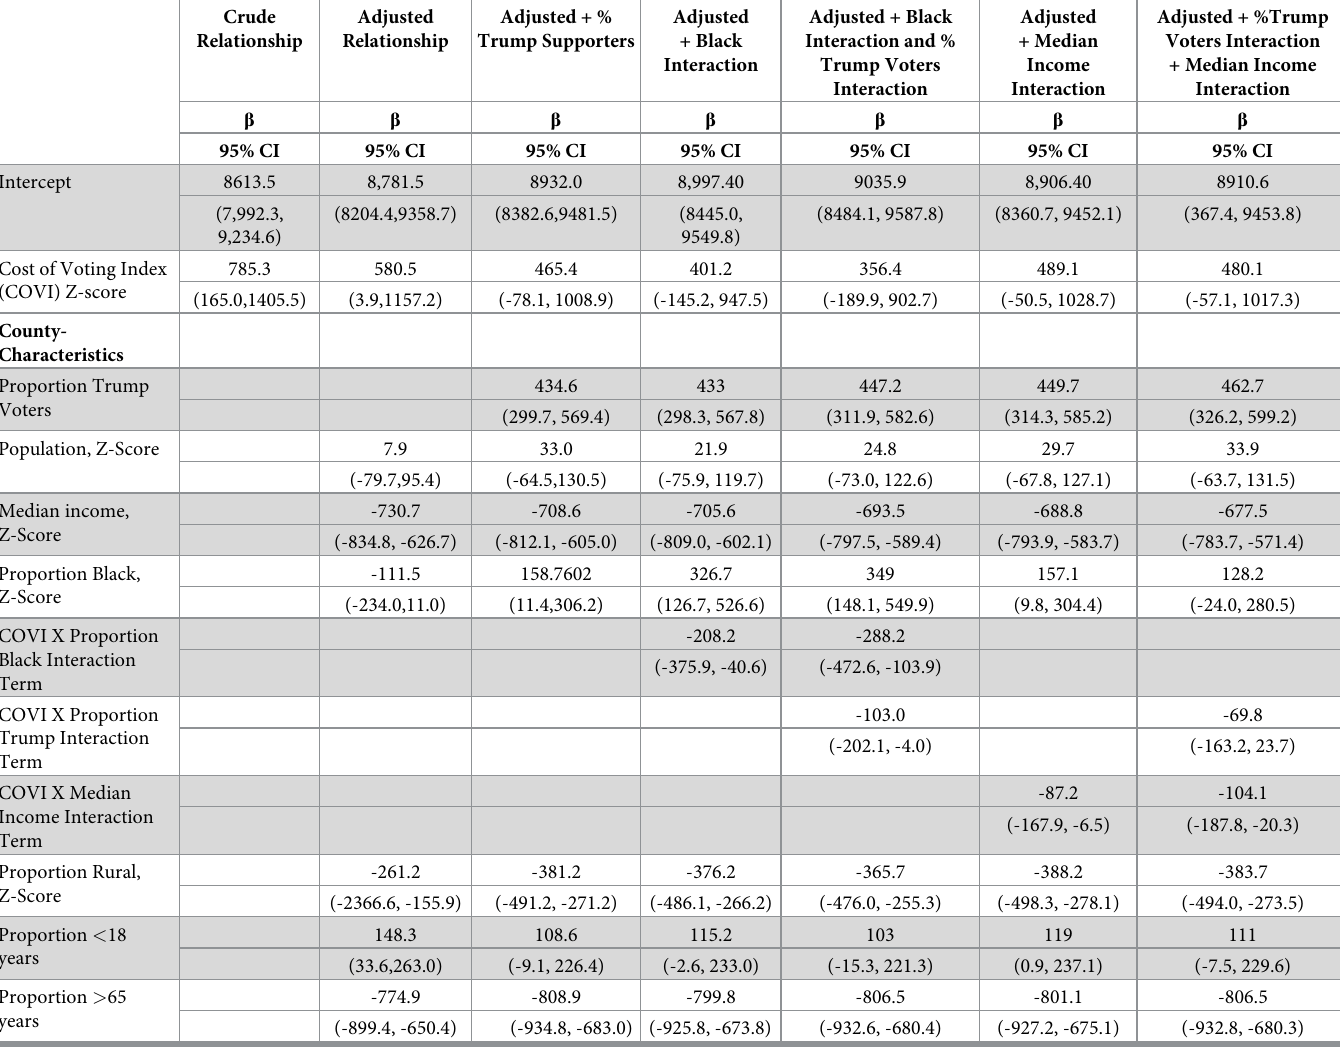
Table 2. The relationship between Cost of Voting Index and COVID-19 case rate during the first year of the pandemic.